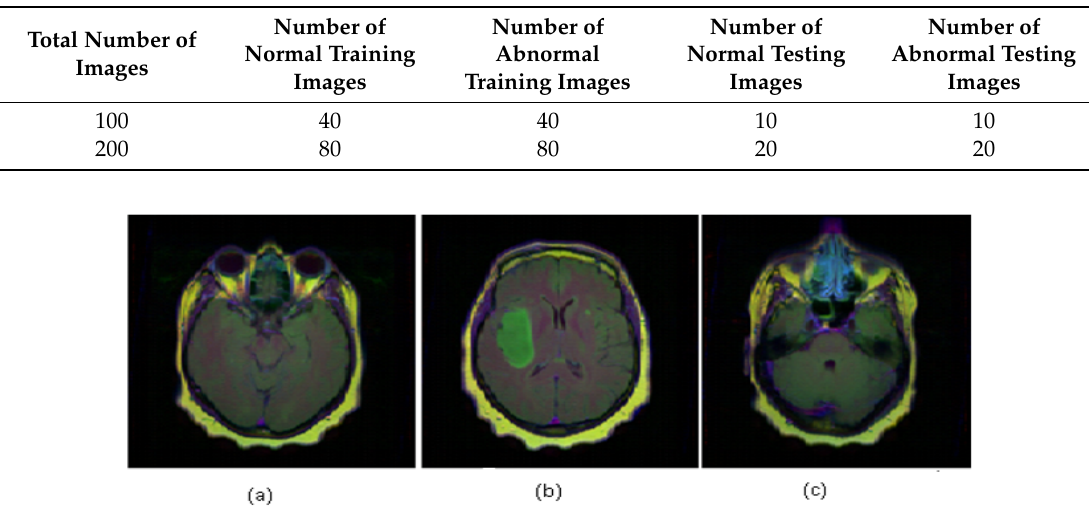
Table 2. Details of 5 × 5-fold stratified cross-validation scheme used.